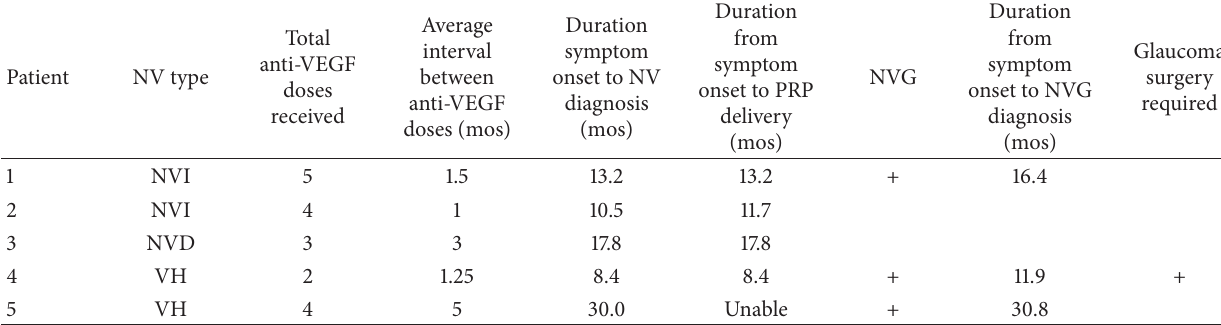
Table 3: Ischemic CRVO eyes with ocular